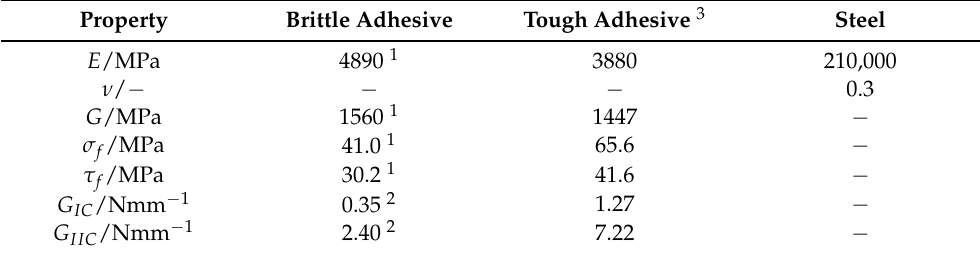
Table 1. Material properties used in the numerical study.